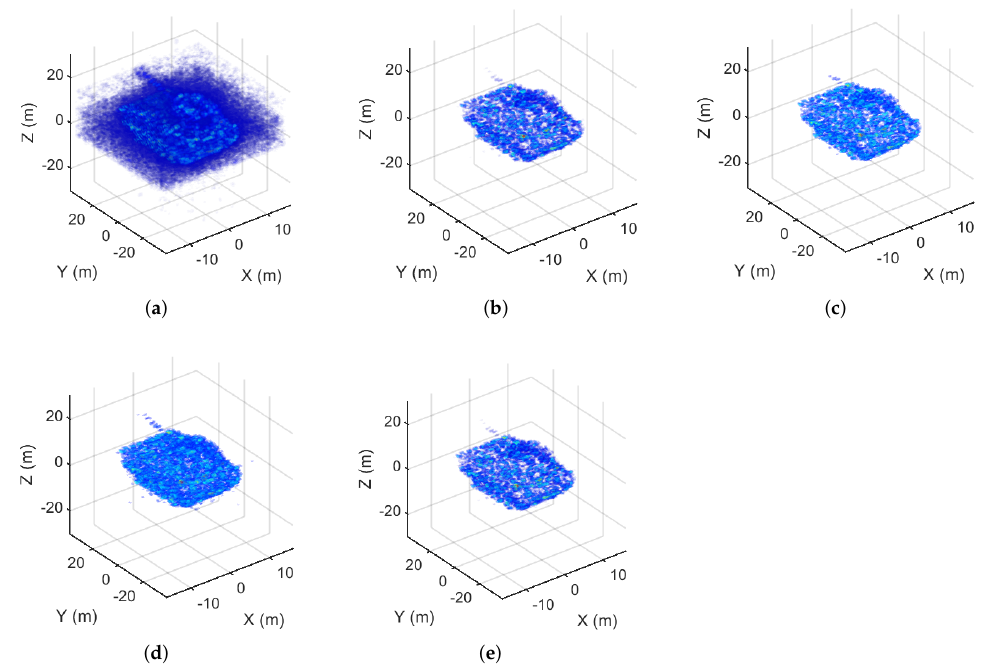
Figure 3. The imaging results of the combat vehicle corresponding to the 75% sampling rate. ( a ) The MF result. ( b ) The MM- L 1 result. ( c ) The MM- L 1/2 result . ( d ) The MM- L 0 result. ( e ) The GMM- L 0.8